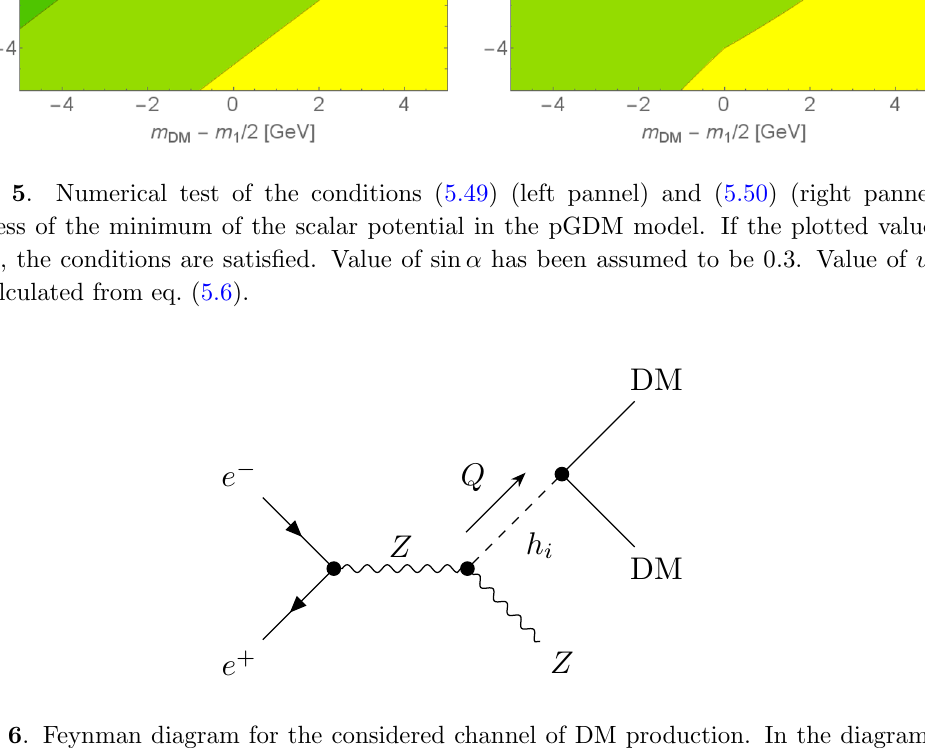
Figure 6 . Feynman diagram for the considered channel of DM production. In the diagram, DM denotes the dark particle that is either A , X or